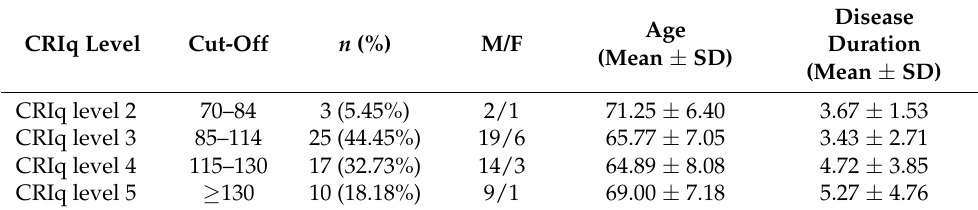
Table 2. Characteristics of the groups based on CRIq levels at